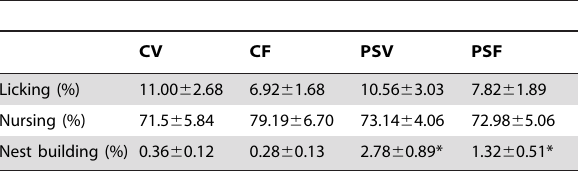
Table 1. Mean ( 6 SEM) percentage of time in maternal behaviors.